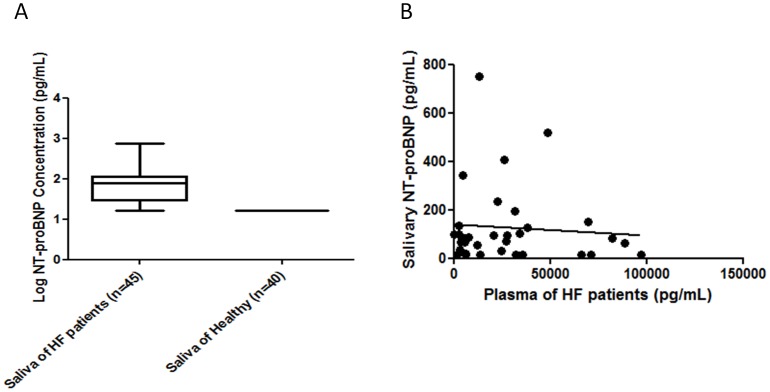
The comparison of the plasma and salivary NT-proBNP concentrations for HF patients (n = 45).(A), NT-proBNP levels in saliva of HF patients (n = 45) and healthy participants (n = 40). (B), The correlation of NT-proBNP concentrations in plasma and saliva of HF patients measured by our NT-proBNP immunoassay.